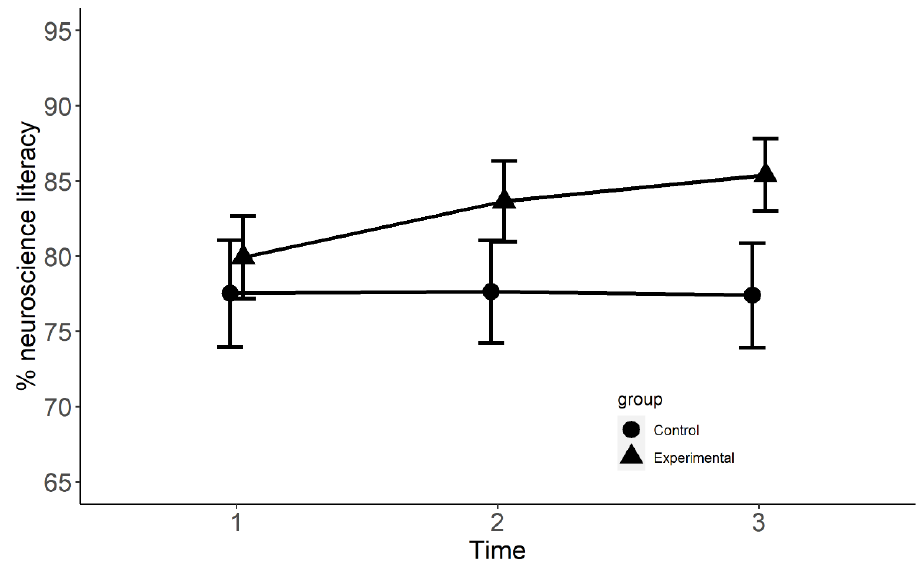
Figure 1. Neuroscience literacy of control and experimental groups at Times 1, 2, and 3.